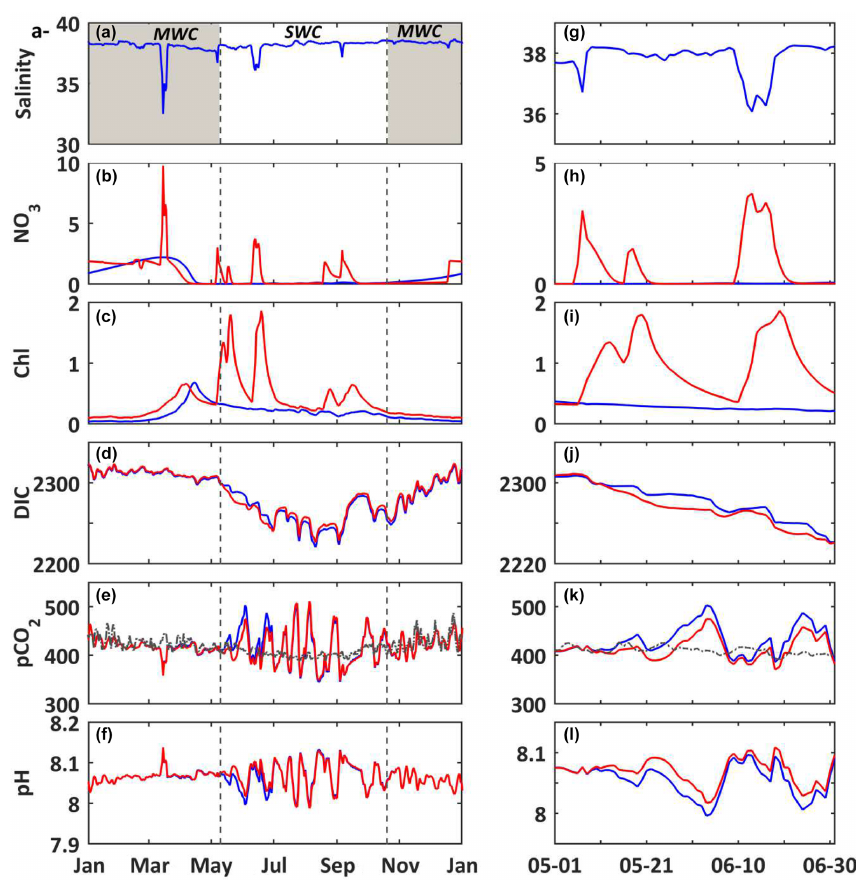
Figure 7. (a–f) 2017. (g–l) Temporal focus between 1 May and 1 July 2017. (a, g) In situ daily average of salinity. Modeled daily average (b, h) nitrate concentrations (mmolm − 3 ); (c, i) chlorophyll a concentrations (mgm − 3 ); (d, j) DIC (µmolkg − 1 ); (e, k) seawater p CO 2 (µatm); and (f, l) pH. Reference simulation ( S 0, blue line) and nitrate supply simulation ( S 4, red line). On (e) and (k) , the dashed line represents the atmosphere p CO 2 (µatm) at the CAV station. The shaded area and dotted black lines delimit the SWC and MWC